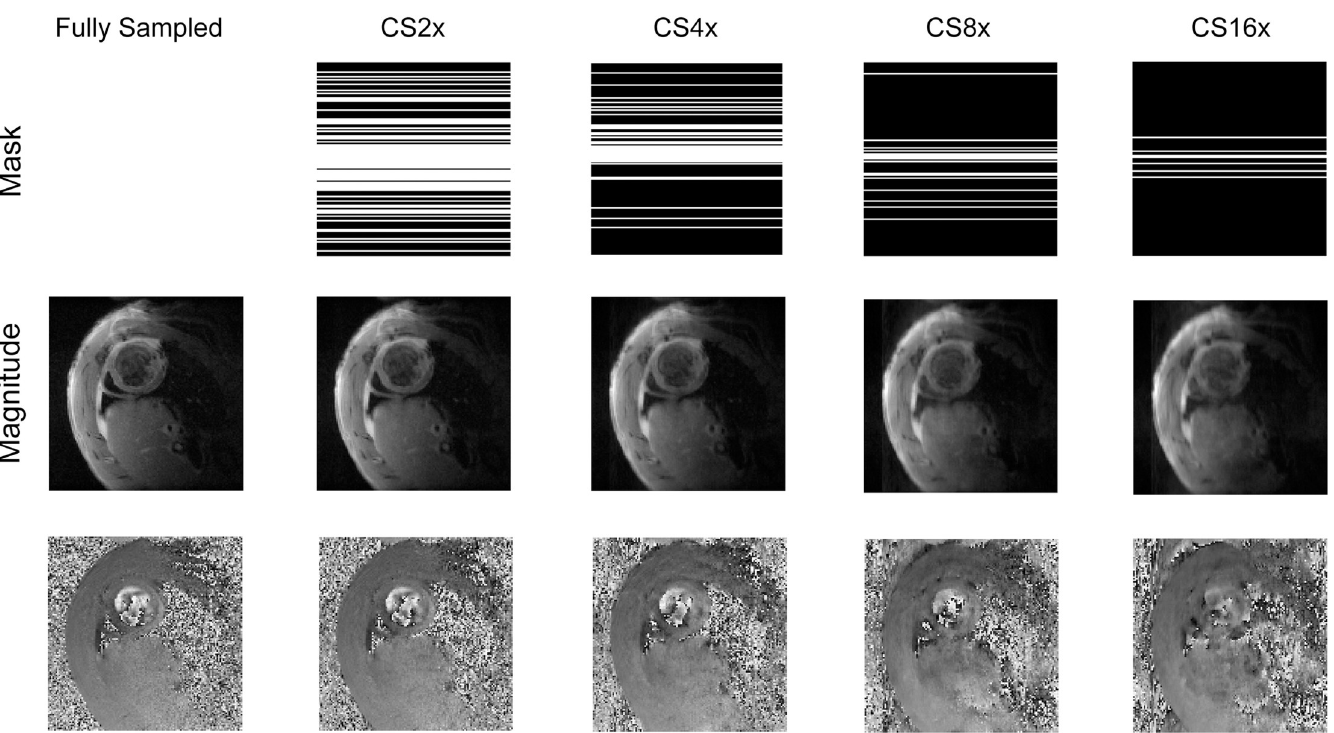
Fig 1. Undersampling masks. An example of representative undersampling masks for different undersampling factors, together with the magnitude data from the CS reconstructions.